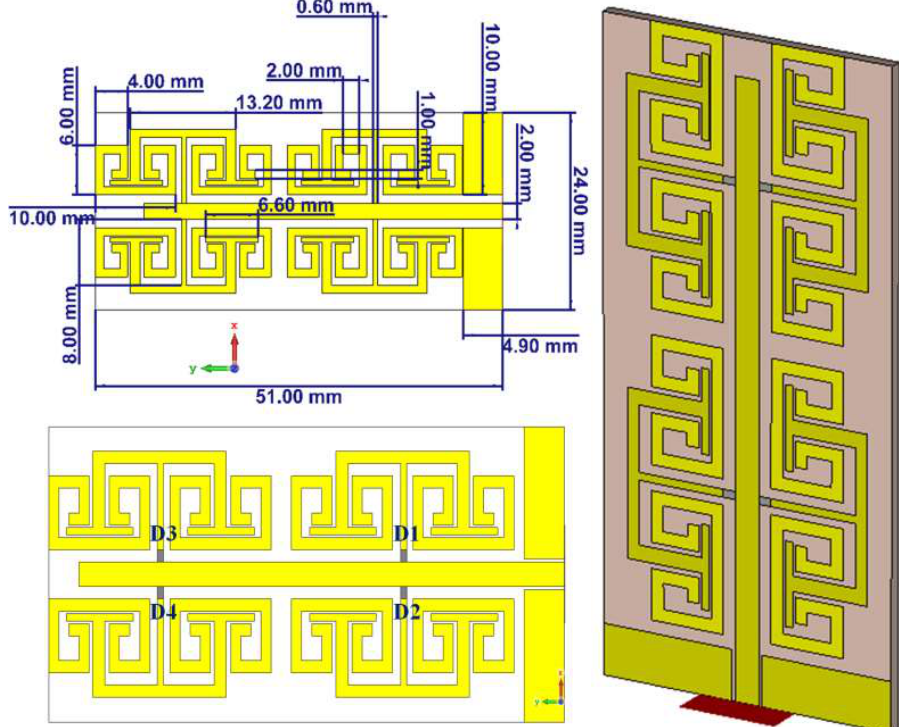
Figure 1. The proposed monopole antenna geometrical details.